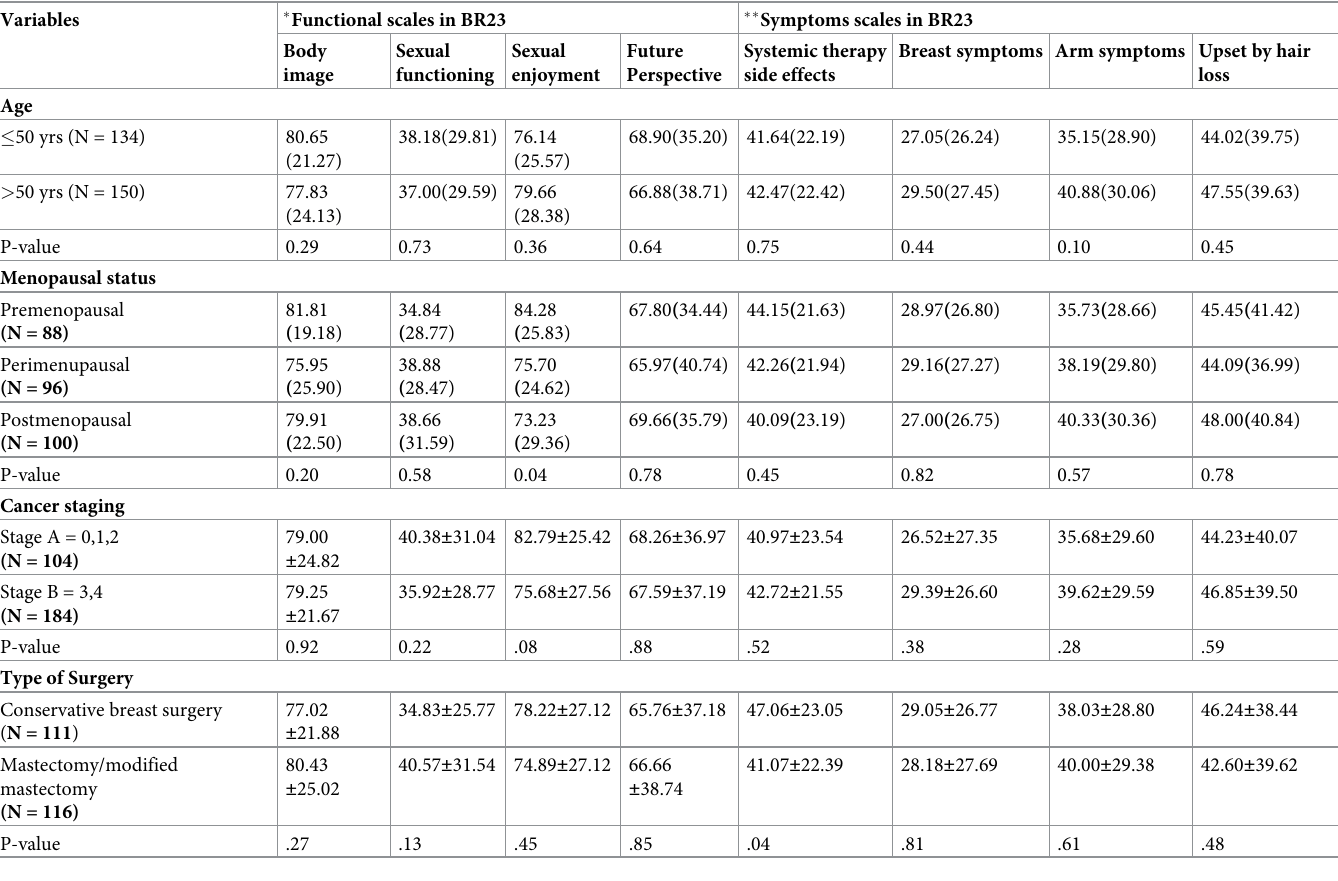
Table 4. Comparison of variables in functional and symptom scales in QLQ-BR23 (N =